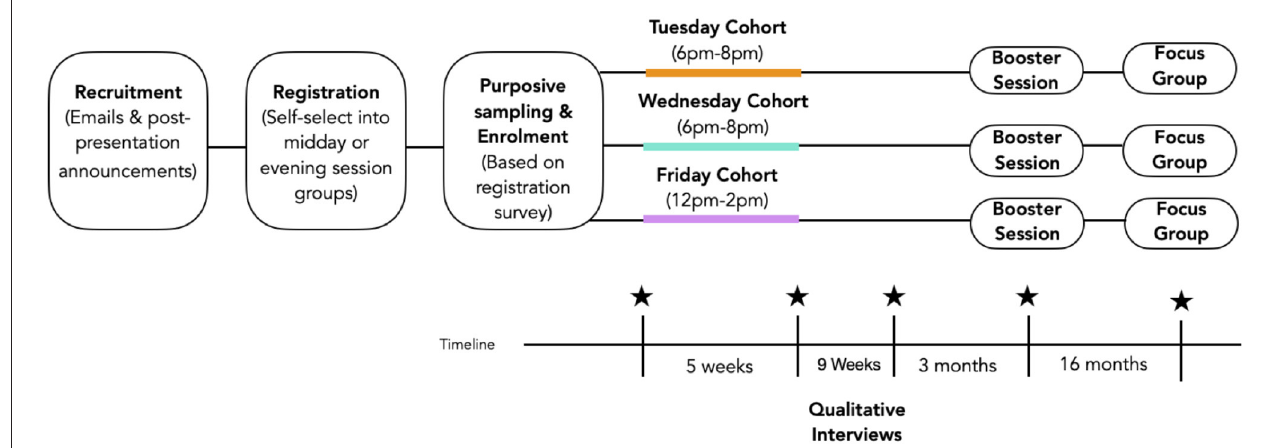
FIGURE 1 | Visual representation of study flow.